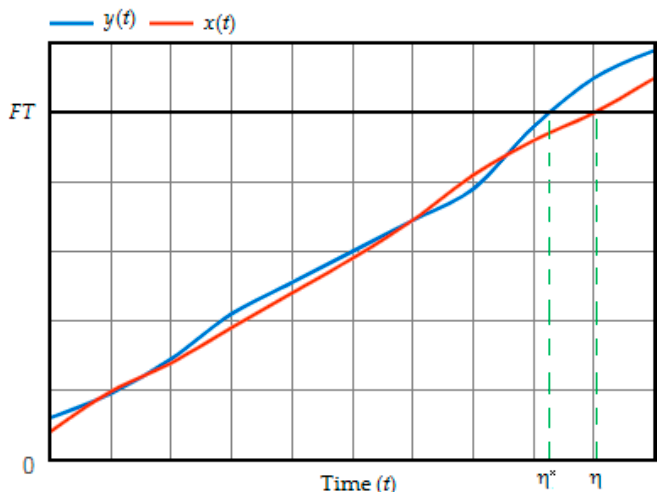
Figure 2. Possible realizations of the stochastic processes X ( t ) and Y ( t ), and the realizations η and η * of the random variables H and H * .